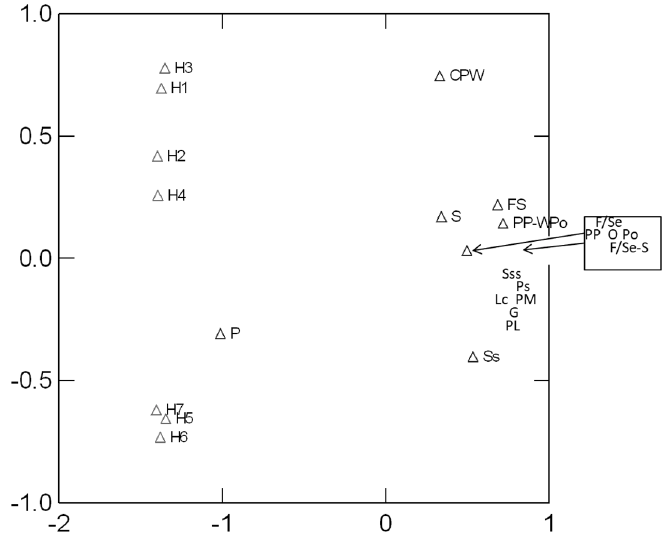
Figure A1 . Diagram of the non-metric multidimensional analysis of habitats and the functional roles of insects according to their insect species content. The diagram space is partitioned in four quadrants. The bulk of the functional roles fall to the positive x -semiaxis. Habitats H1-H4 fall in the second and the rest of habitats fall in the third one together with the predatory insects.